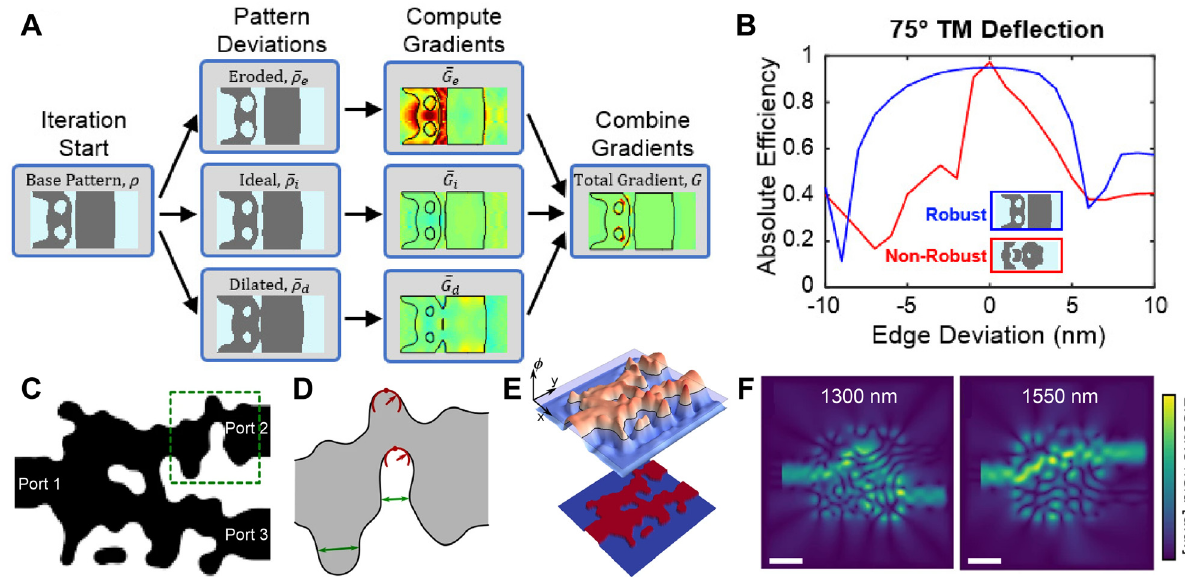
Figure 15: Methods for imposing fabrication constraints into free-form optimization and its results. ( A )Three-levelrobustness-controlschemebasedondensity fi lter,appliedtobeamde fl ectoroptimization.( B )Absoluteef fi ciencydependence on edge deviation of optimized structures, with andwithout robustness-control. Inset shows fi nal optimizeddevice structures for both cases. A , B adapted with permission from [33]. Copyright 2019, Optical Society of America. ( C ) Schematic of binary represented waveguide demultiplexer. Port 1, 2, and 3 are input, desired output for 1300 and 1500 nm, respectively. ( D ) Magni fi ed view of greenbox placed in ( C ). Red arcs and green lines show curvature and gap of the structure shown in ( C ), respectively. ( E ) Illustration of the level set function corresponding to the structure of ( C ) (top). The zero-level contourof the level set function decidesthe boundaryof the physicalstructure (bottom). ( F ) Electric fi eld intensity plot of the optimized structure at wavelengths of 1300 nm (left) and 1550 nm (right), respectively. The scale bar is 0.5 µm. C – F adapted with permission from [126]. Licensed under CC BY